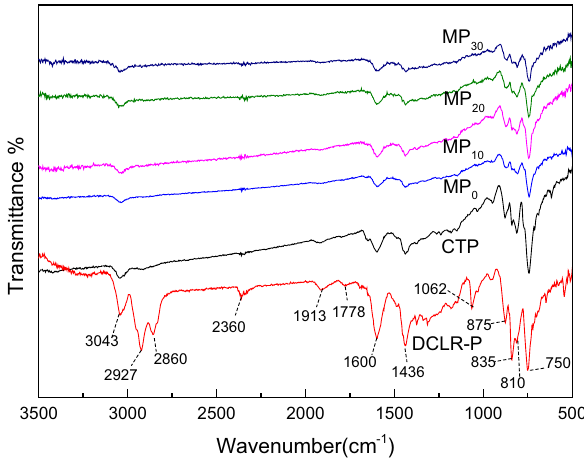
Fig. 5 FTIR spectra of CTP, DCLR-P and